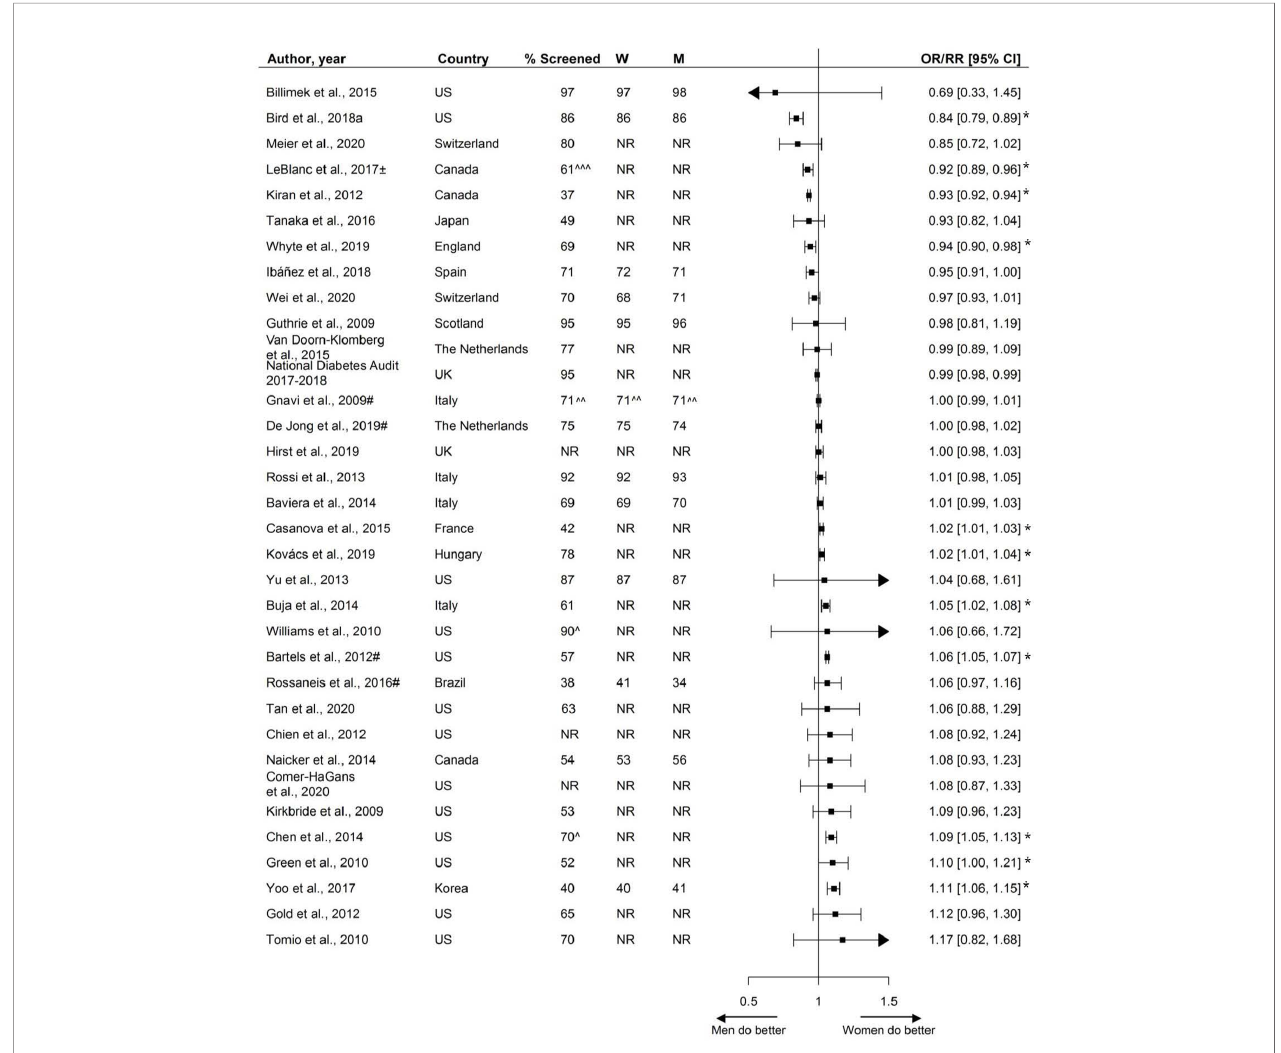
FIGURE 2 | Assessment of HbA1c, expressed as adjusted odds ratios (OR) or relative risks (RR) with corresponding 95% con fi dence intervals (CI). Two studies are not presented in this fi gure because of their measure of association: Swietek et al. (33): Average Marginal Effect, (SE; p-value): − 0.00031 ( − 0.0044; >0.05), Du et al. (92): Prevalence difference (95% CI): 3.5 ( − 1.0;8.0). W = % of screened women; M = % of screened men; US, United States; UK, United Kingdom; ± = 99% CI; # = Relative risk; ^ Weighted %; ^^ = Kaplan-Meyer estimates; ^^^ = Estimated %; * = statistically signi fi cant. Men =